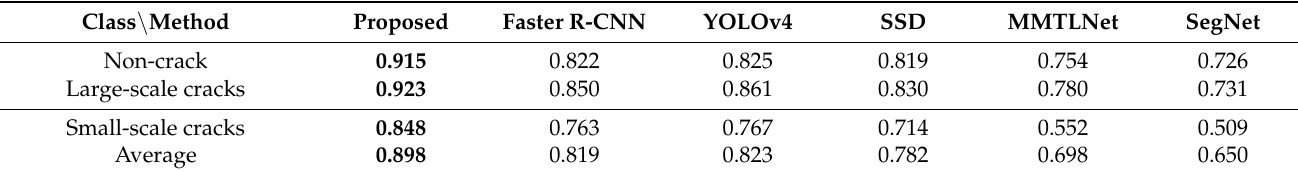
Table 3. Algorithms comparison in crack location accuracy.